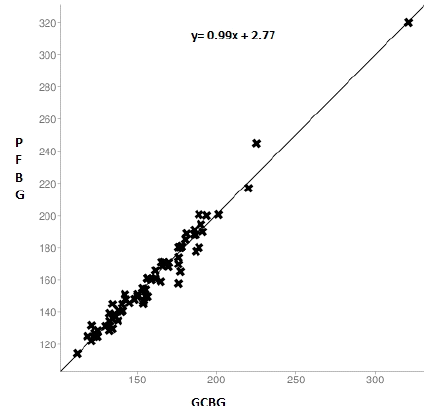
Figure 1. Scatter plot of the linear relationship between the glucose measurements of the gingival blood and capillary finger-stick method in the diabetic group. GCBG: comparison of gingival crevicular blood glucose.